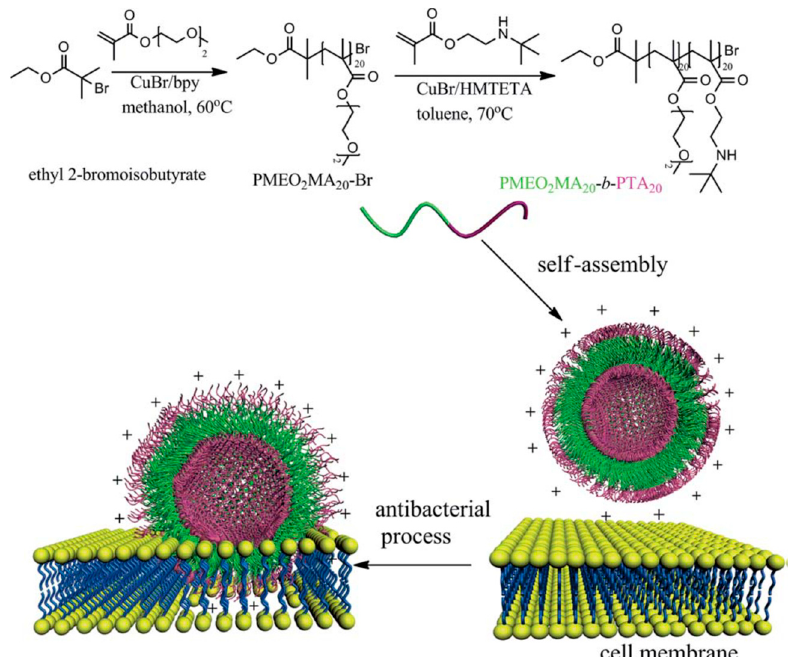
Figure 4. Polymer vesicles by direct dissolution of a diblock copolymer in water, exhibiting a superior antibacterial activity to their linear counterparts. Green: the thermo-responsive PMeO 2 MA block forms the vesicle membrane at 37 °C; purple: the antibacterial PTA block forms the vesicle corona [53] (Reprinted with permission from [53]).